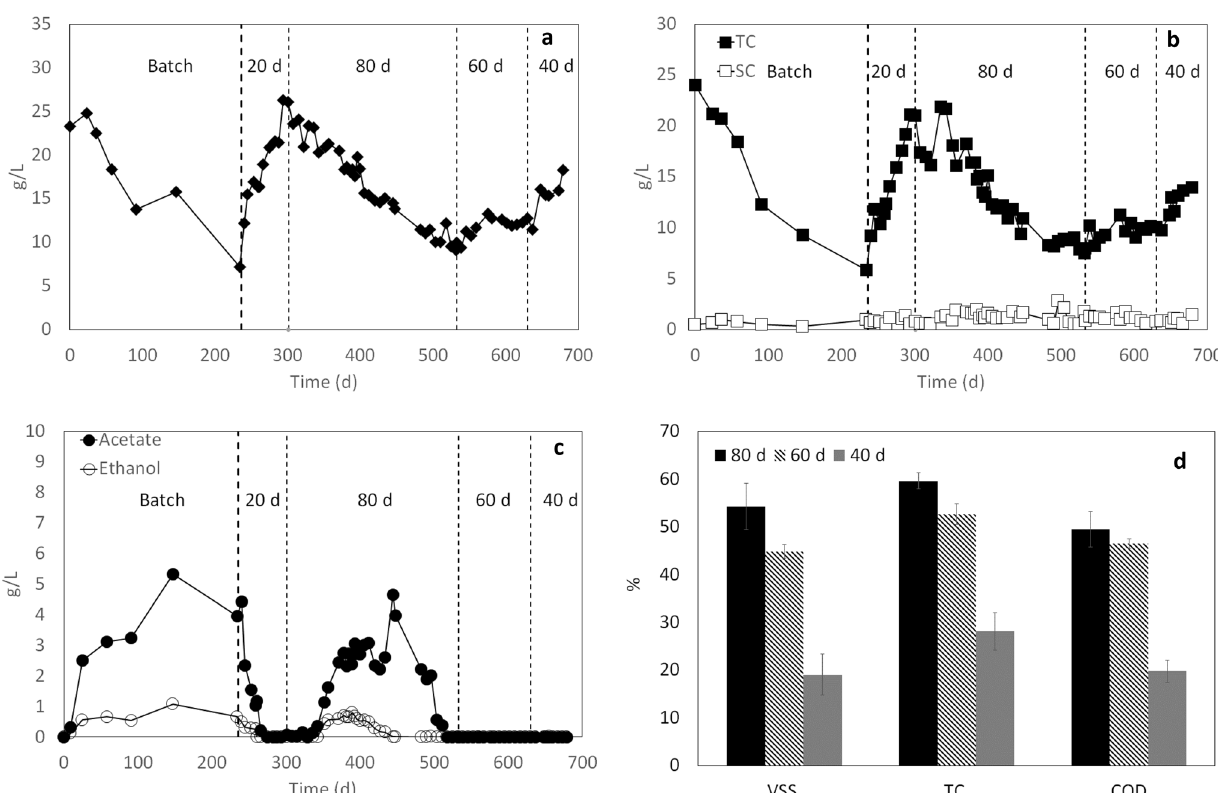
Fig. 3 Experimental data for Run B. a VSS; b TC and SC; c liquid-phase products; d average removal at steady state in the semi-continuous mode at different residence